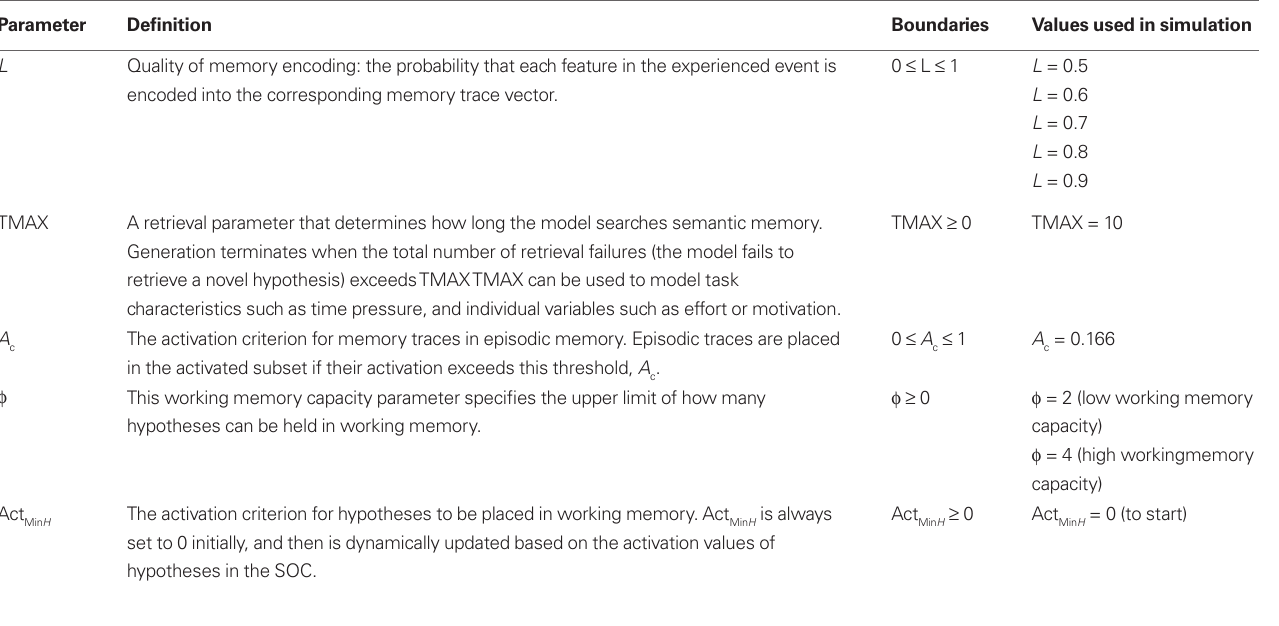
Table 1 | HyGene parameters, definitions, boundary values, and values used in the